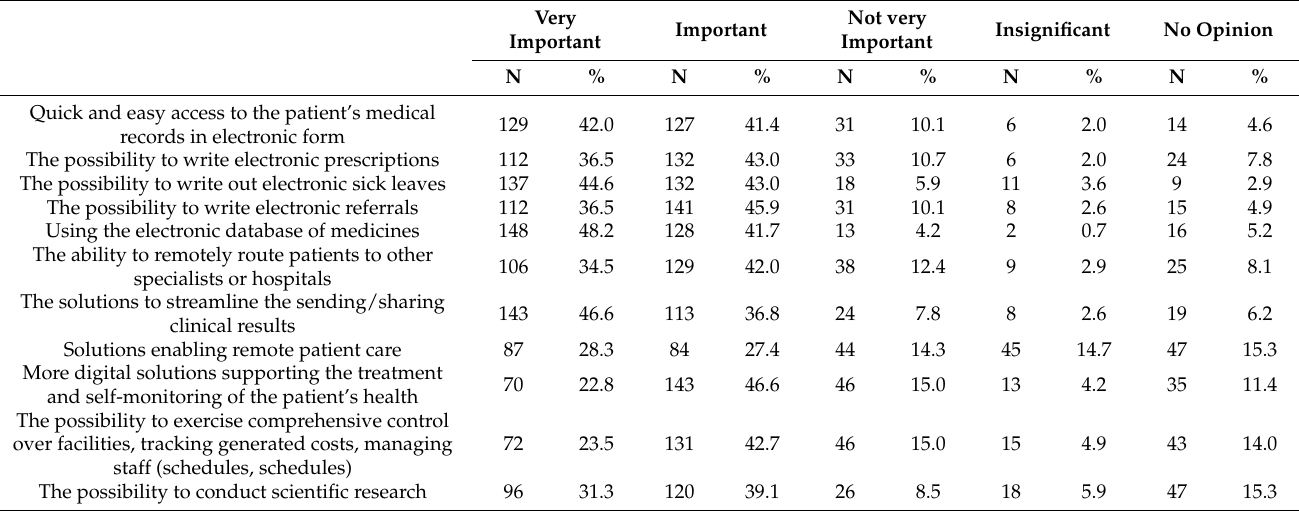
Table 8. Physicians’ opinion about selected e-Health solutions.